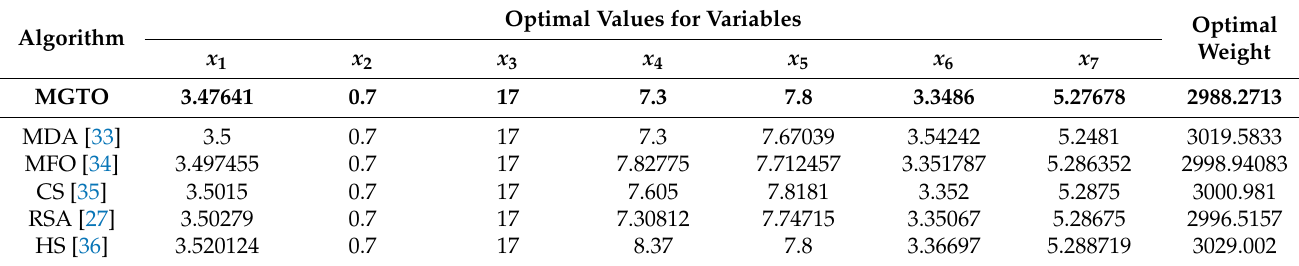
Table 10. Experimental results of the speed reducer design problem